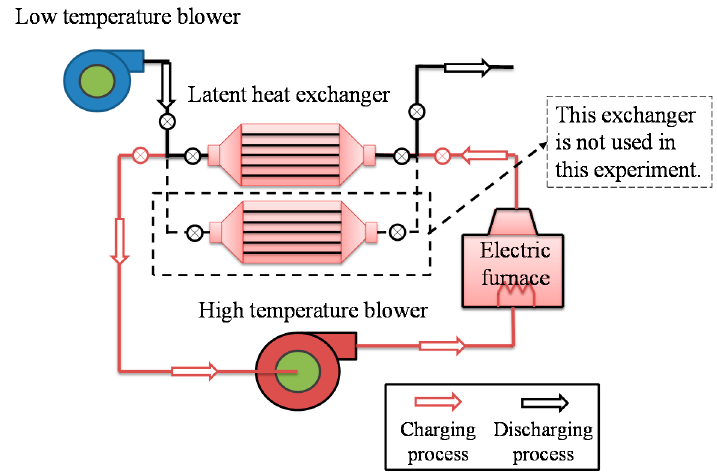
Figure 3. Experimental system.